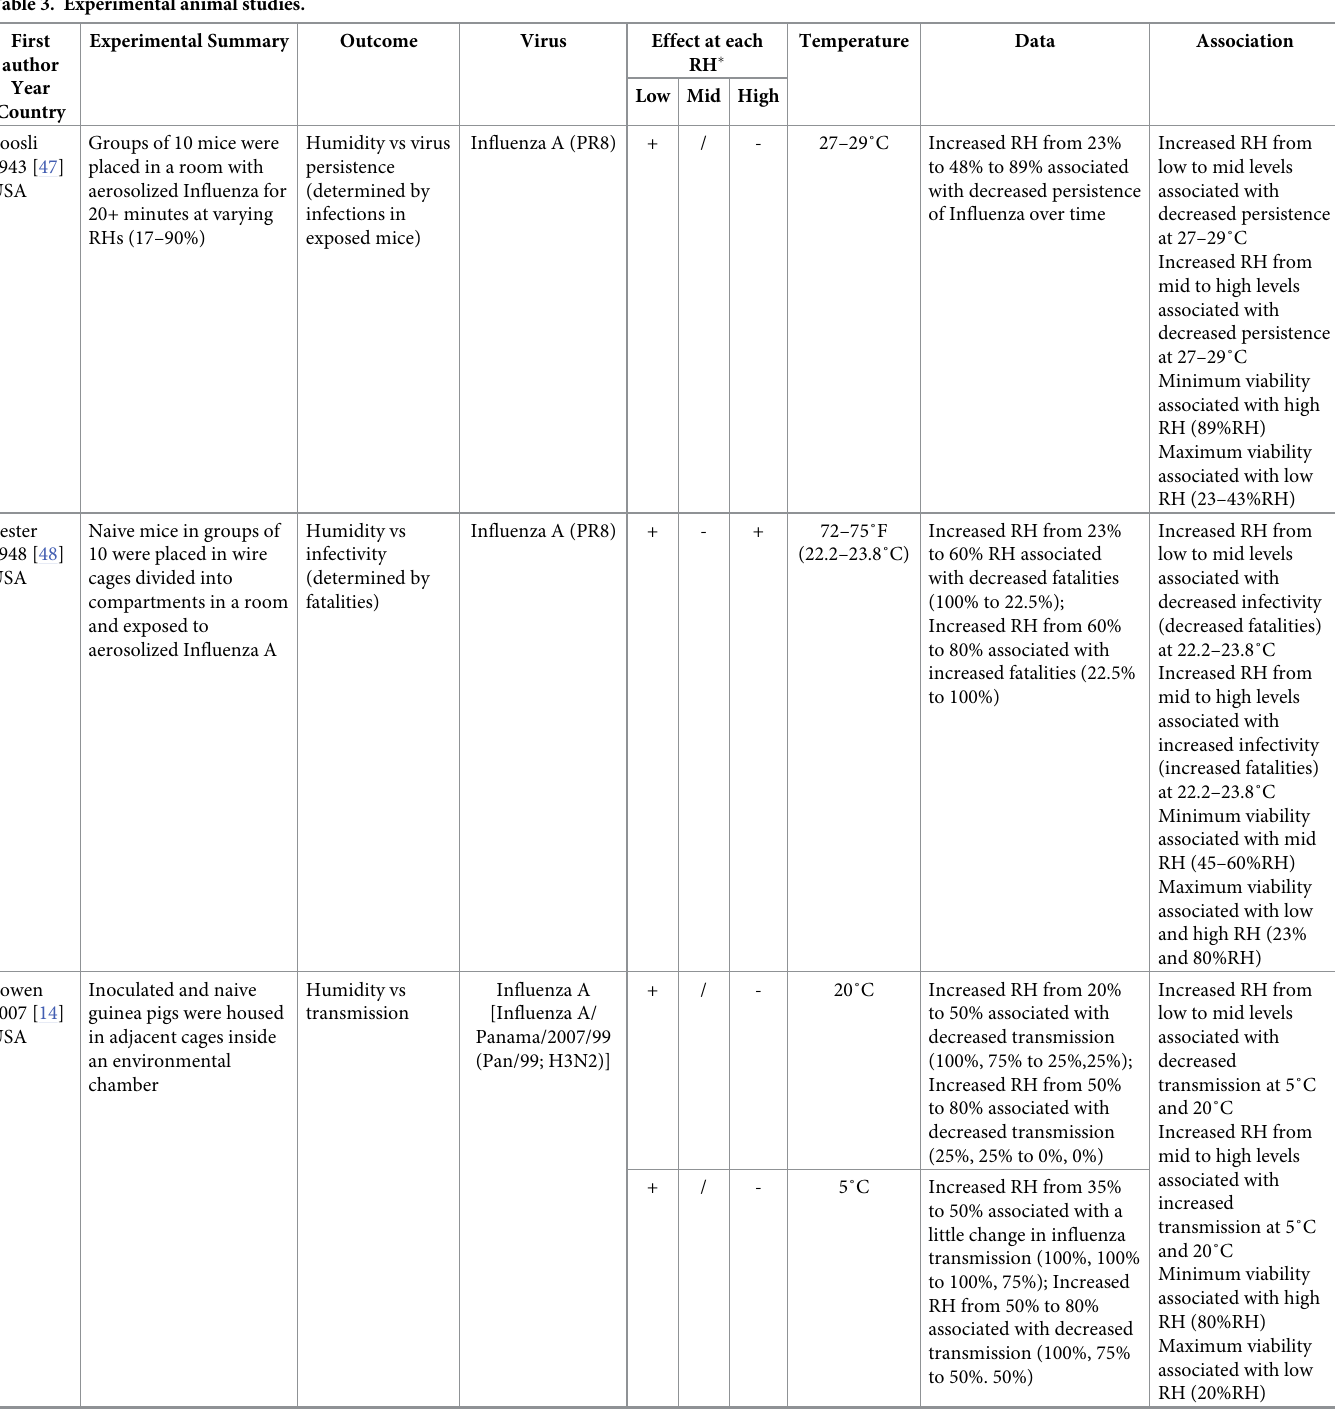
Table 3. Experimental animal